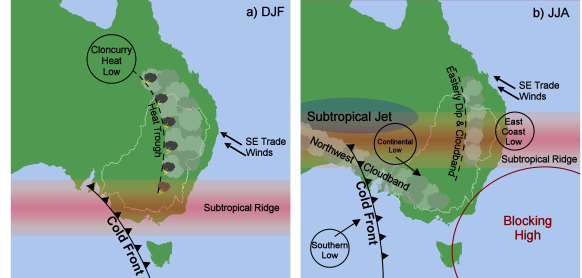
Fig. 4. The key weather systems that affect the Murray-Darling Basin during the austral (a) summer (December-January-February) and (b) winter (June-July-August). The southern half of the Basin is primarily affected by extra-tropical systems and receives the major- ity of its annual rainfall during the cooler months (May–October). The northern half of the Basin is primarily affected by tropical sys- tems and interactions between tropical and extra-tropical systems and receives the majority of its annual rainfall during the warmer months (November–April). The systems that tend to suppress rain- fall are shown in